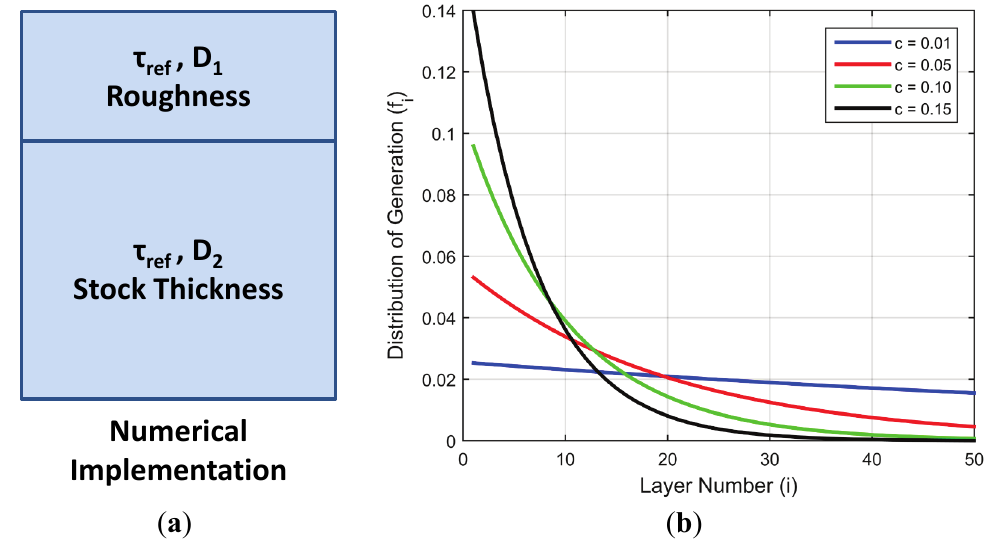
Figure 2. ( a ) Schematic of the two-layered structure used for modelling adsorbed-type PC-PSP; ( b ) Distribution of generation for different values of c